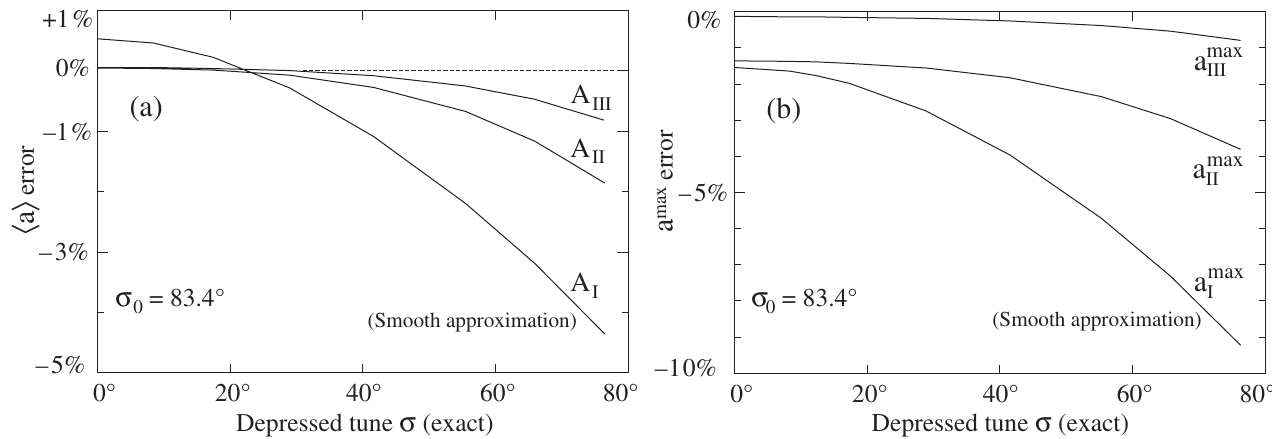
FIG. 1. Illustration of results for special case of FODO lattice, compared with simulation results. (a) Accuracy of mean radius, from Eqs. (34), (36), and (37). (b) Accuracy of maximum radius, from Eqs. (40)–(42). Input quantities: Q , 2 , and quad voltage V Other parameters: see Table II. V , fixed at 20 kV, gives phase advance (cid:2) of 83 : 37 (cid:10) ; 2 and Q are varied so that depressed tune (cid:2) Q 0 and (cid:2) were obtained numerically. ranges between 0 (cid:10) and 76 : 5 (cid:10) ; exact (cid:2) 0